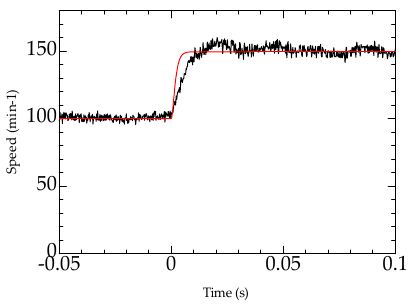
Figure 13. Step response of the initial PI ‐ P gain controller.